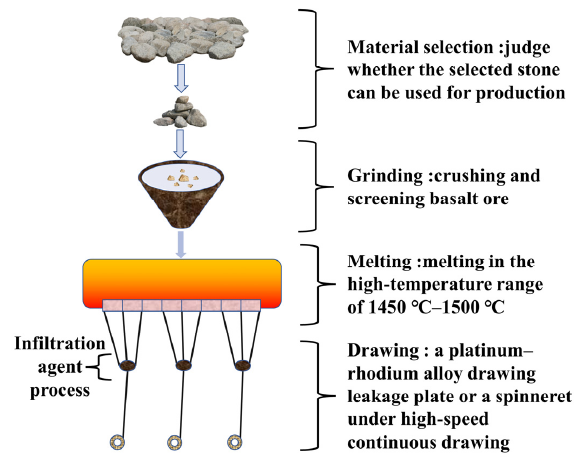
Figure 2. BF production process